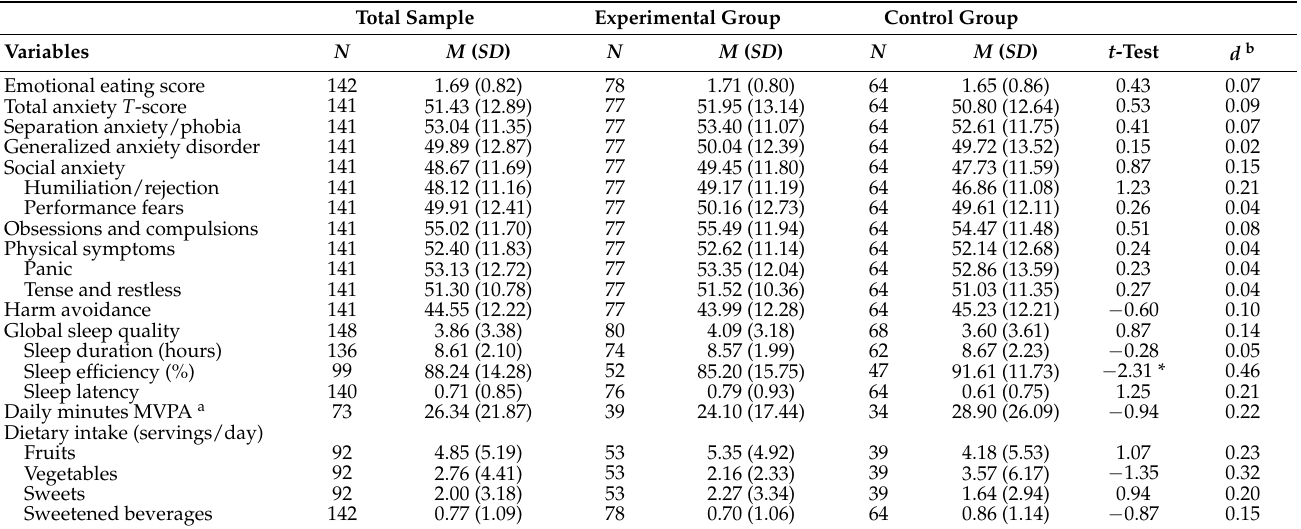
Table 2. Comparison of baseline means and standard deviations of key variables between the experimental and control